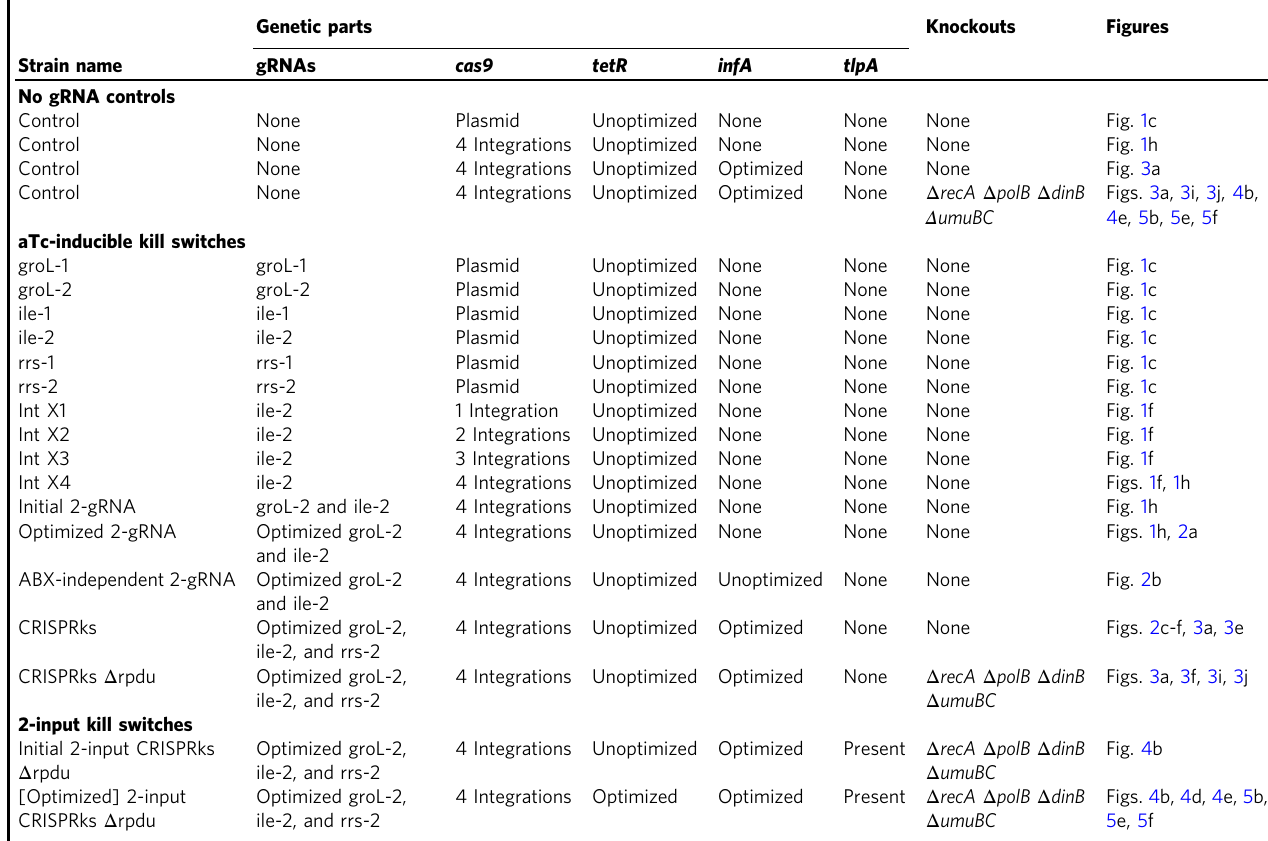
Table 1 Names and descriptions of each no gRNA control and kill switch strain. Cas9-expressing plasmids include a low